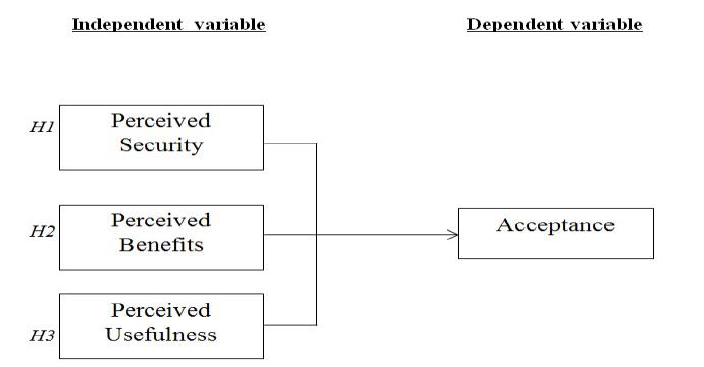
Figure 2: Theoretical Framework